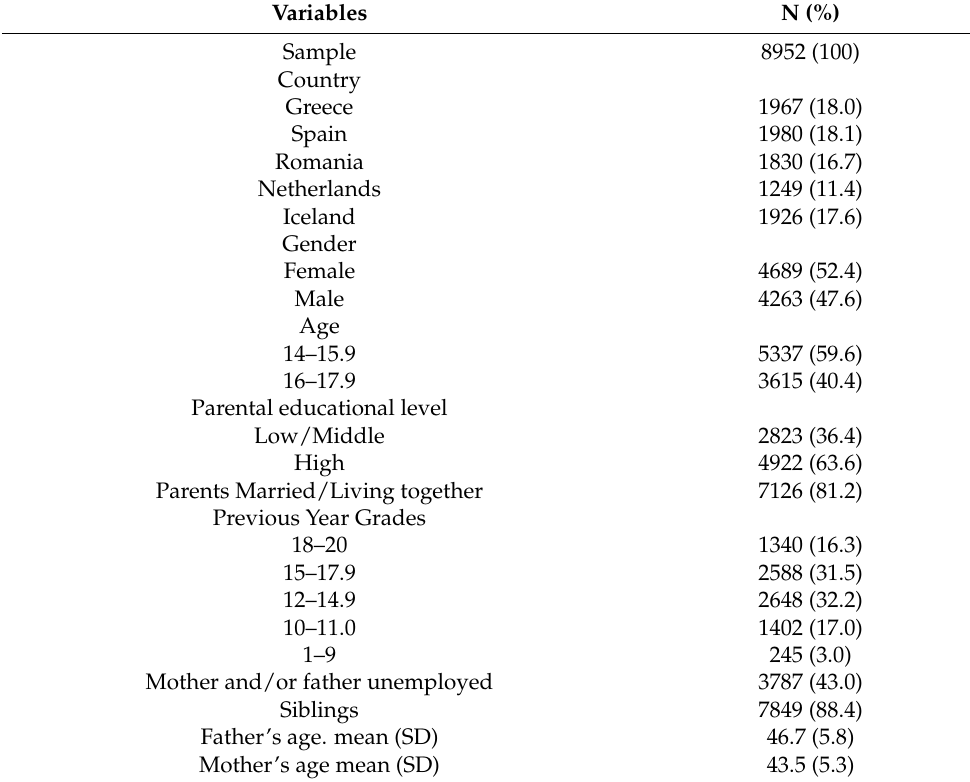
Table 1. Sample characteristics (N = 8952).